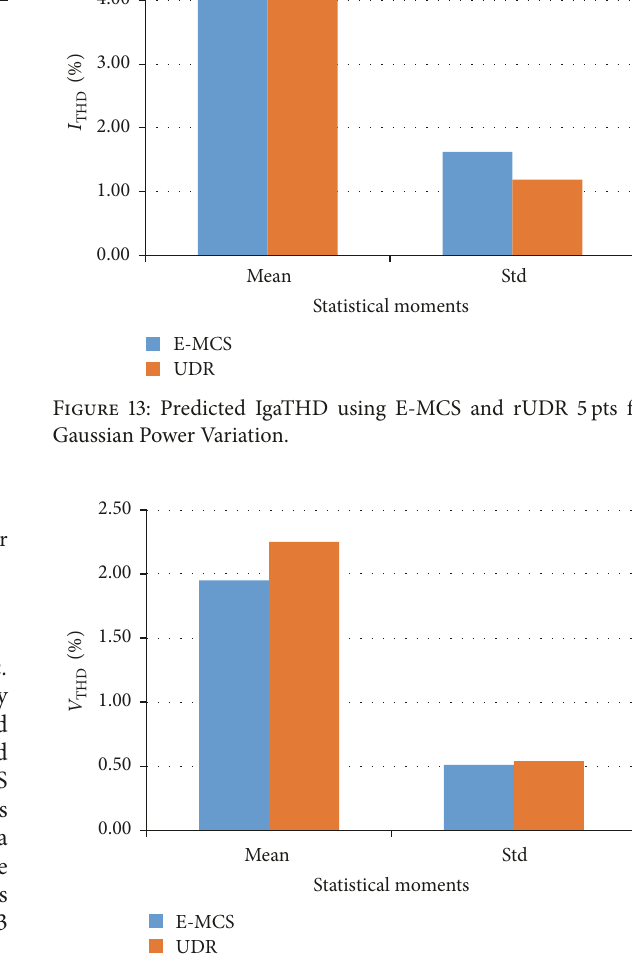
Figure 14: Predicted VgaTHD using E-MCS and rUDR 5pts for Gaussian Power